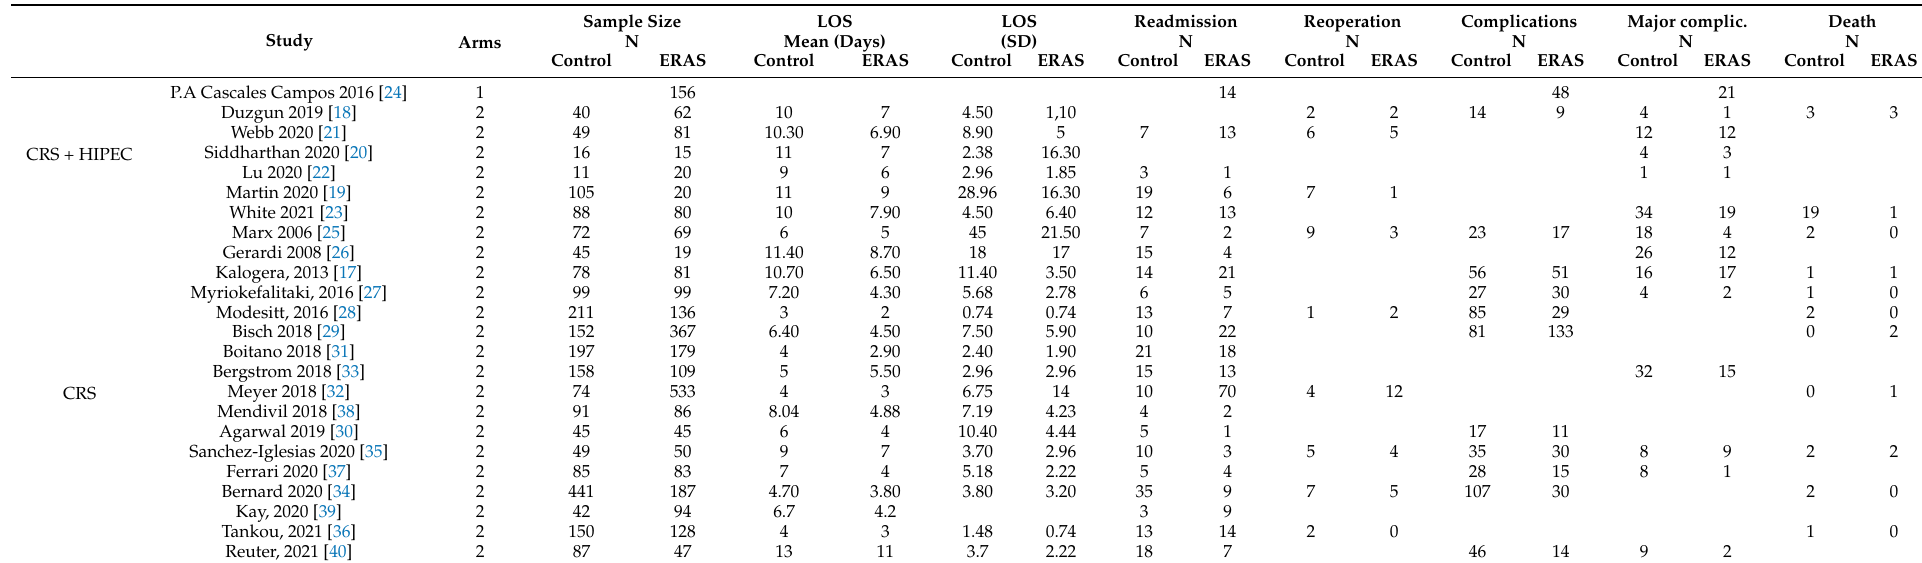
Table 3. Details of outcomes of the included studies.